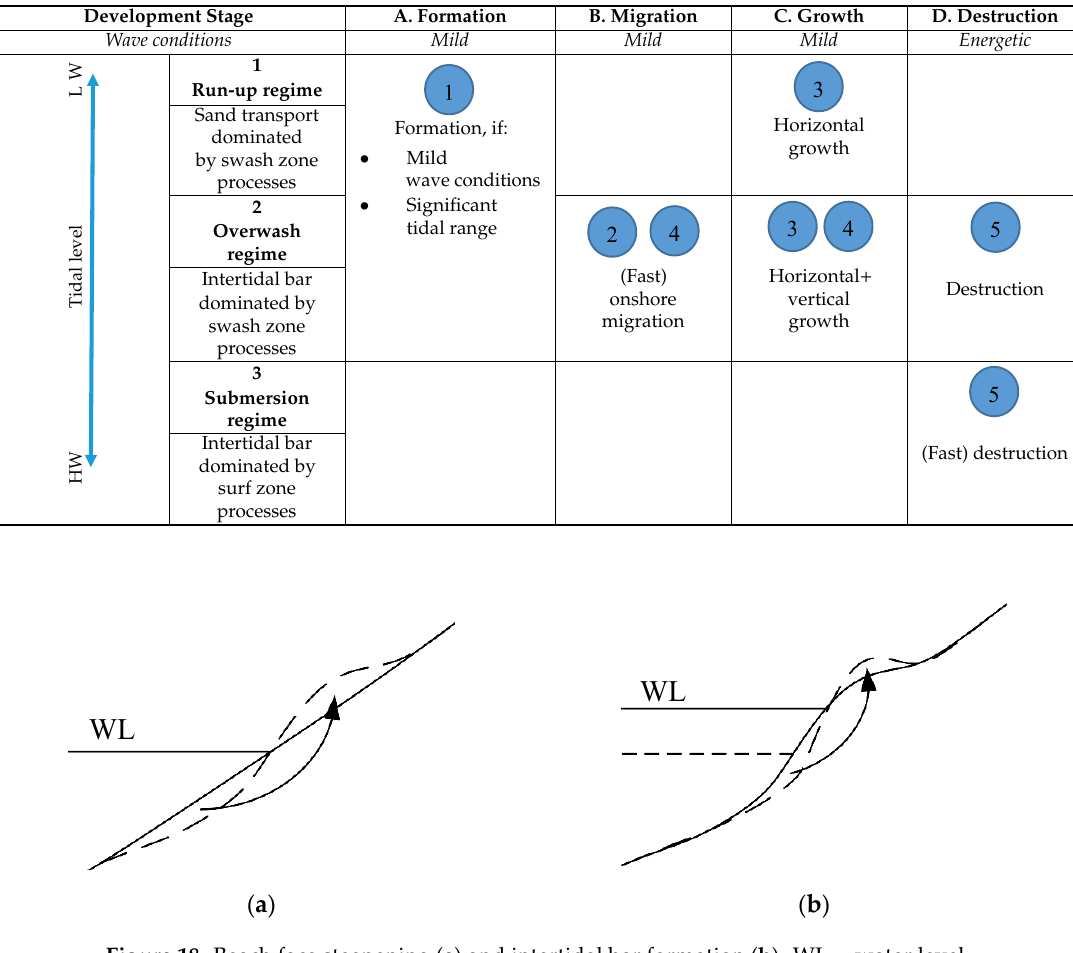
Figure 18 . Beach face steepening ( a ) and intertidal bar formation ( b ). WL = water level. Figure 18. Beach face steepening ( a ) and intertidal bar formation ( b ). WL = water